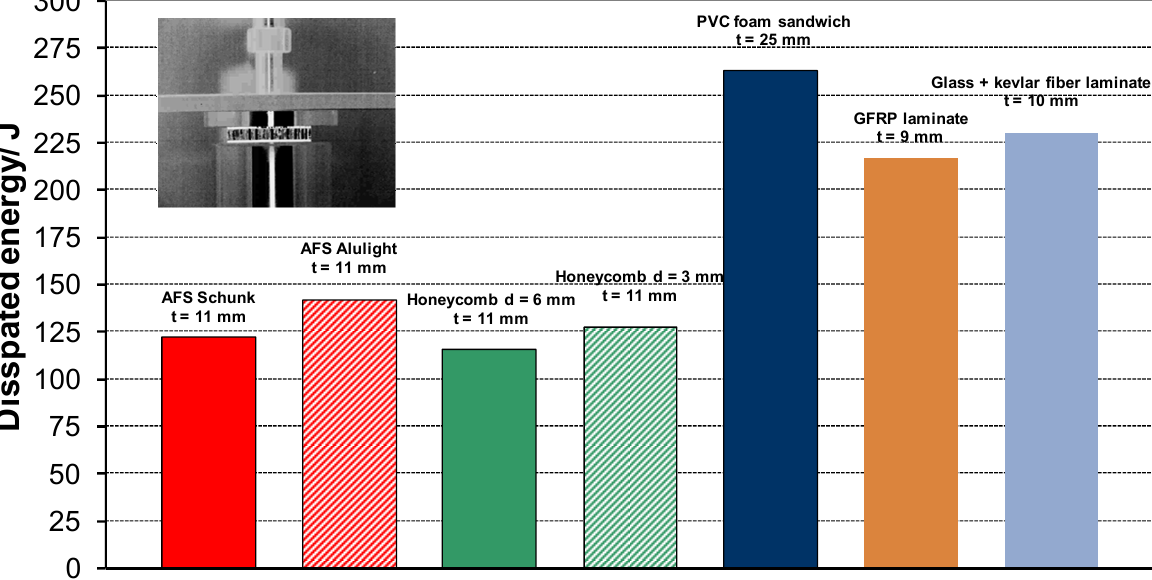
Figure 18: Energy required to produce complete failure of the investigated